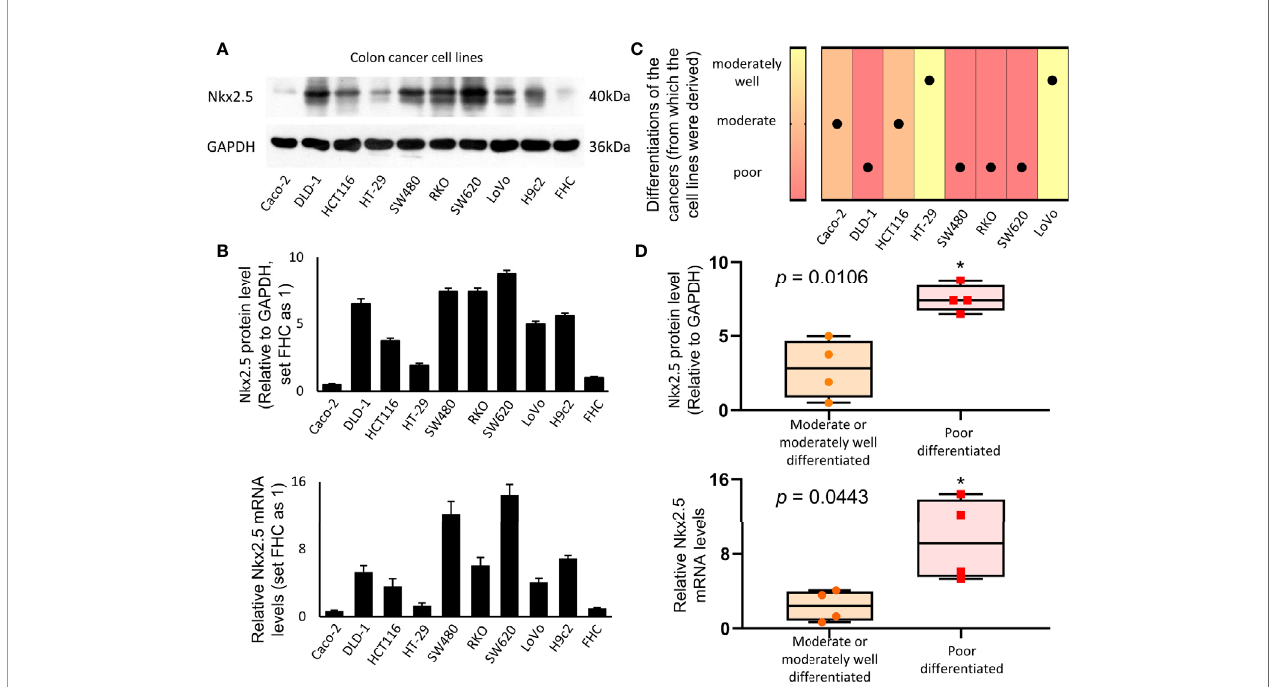
FIGURE 2 | Higher expression of Nkx2.5 in poorly-differentiated CRC cell lines. (A) Western blotting was used to identify the expression of Nkx2.5 in CRC cell lines (H9c2 and FHC serve as positive and negative controls, respectively). (B) RT-qPCR was used to detect Nkx2.5 mRNA level in CRC cell lines. (C) Pathological differentiation degrees of the original CRC tissues. (D) Nkx2.5 protein and mRNA levels in the moderately- or well-differentiated CRC cell lines compared with poorly- differentiated CRC cell lines. The upper and lower bars indicate the maximum and minimum values, respectively. * represents P <